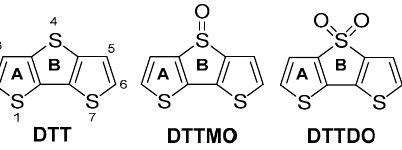
Figure 3. Structure, ring letters (A, B), and atom numbering of DTT and its oxidized derivatives. Table 2. Calculated aromaticity indexes, dual descriptors, and energy of frontier orbitals of DTT , DTTMO, and DTTDO .